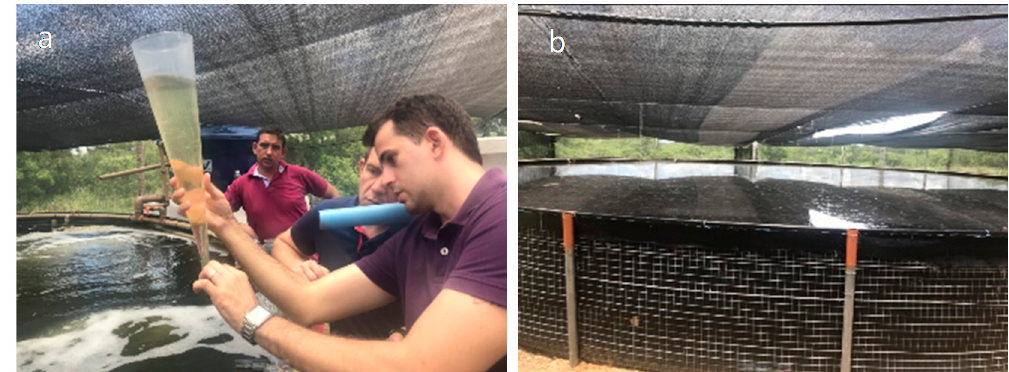
Figure 1. Recirculation aquaculture system for tilapia production exploited in PISCIS company.